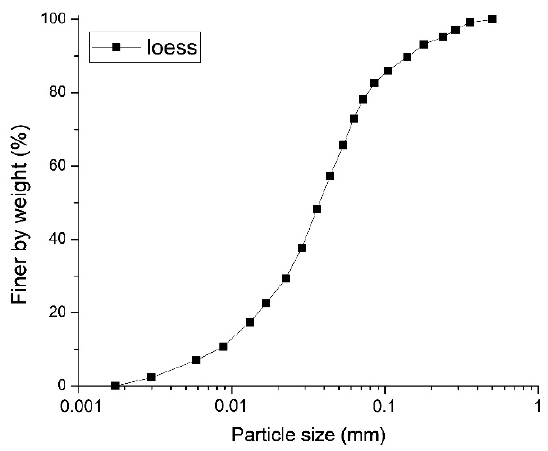
Figure 1. Particle size gradation curve of loess.